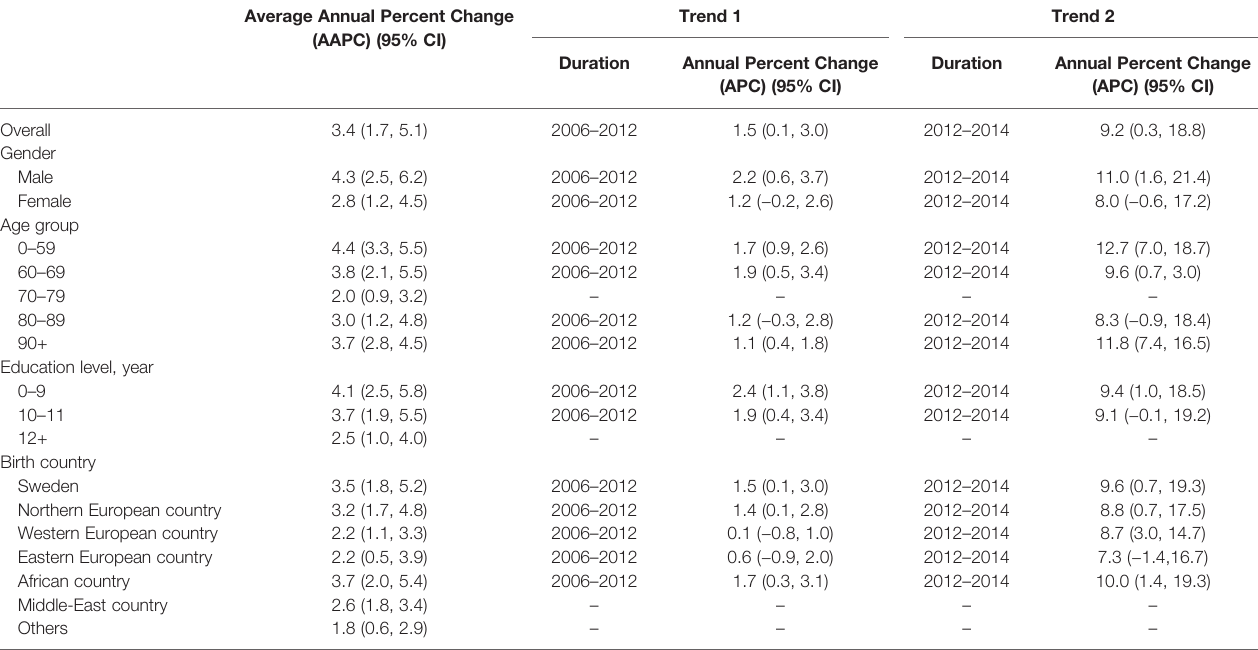
TABLE 5 | Results of joinpoint trend analysis for excessive